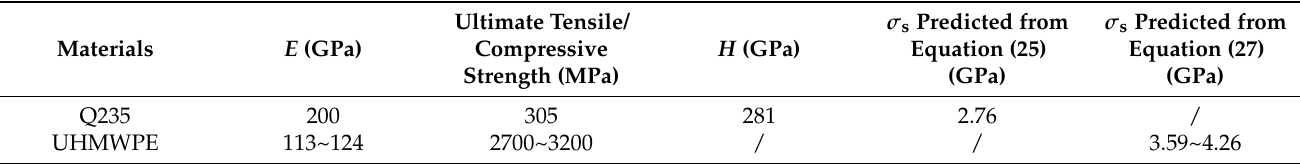
Table 10. The predicted value of quasi–static radial stress σ